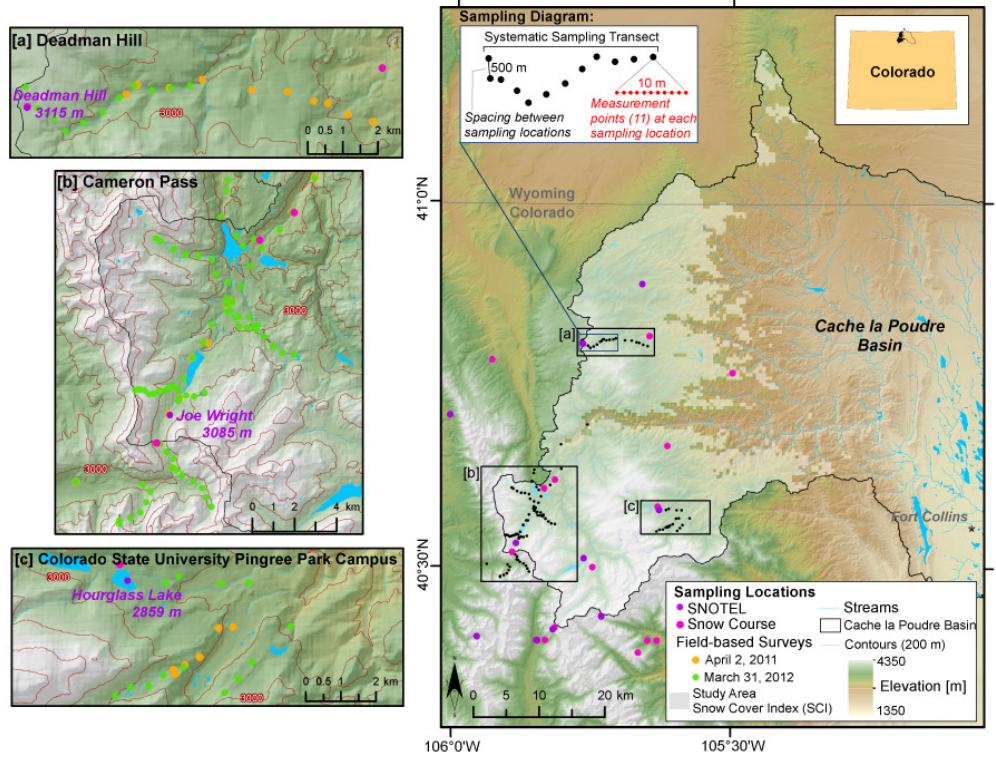
Fig. 1. The Cache la Poudre Basin located in the northern Front Range of Colorado, USA. The study area is represented by the 50% Snow Cover Index (SCI) which is indicated by the transparent light gray color within the basin. The locations of operational and field-based snow measurements are shown, including a detailed sampling diagram of one systematic field-based sampling transect.